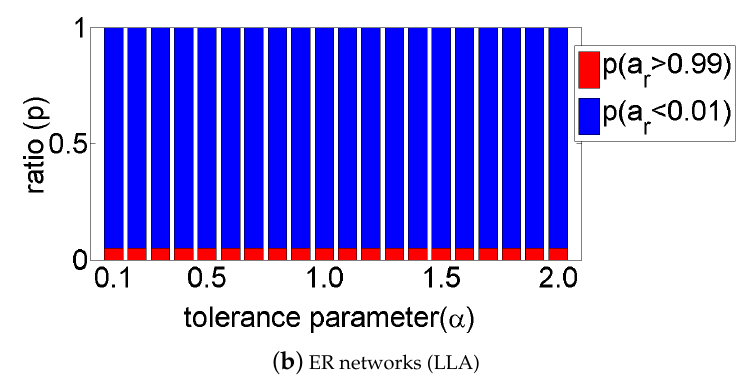
Figure 3. Probabilities of the extents of cascading failures for three network types under lowest loads attacks.